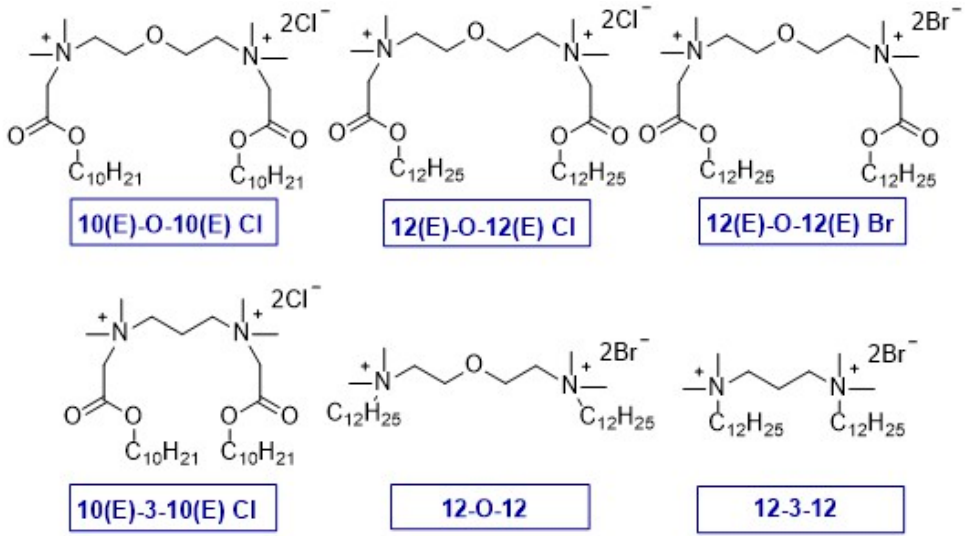
Figure 2. Chemical formulas of obtained gemini surfactants.